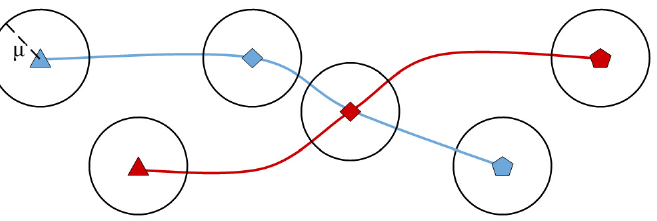
Figure 7. The two lines represent the path taken by two UAVs, while the shapes represent their positions at different times. It is easy to appreciate how, despite intersecting trajectories, collisions are not possible.